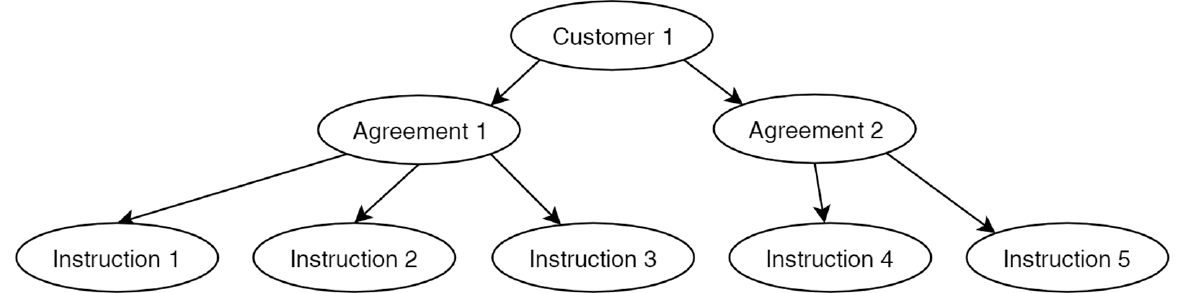
Figure 18. The graphical representation of the physical data model.